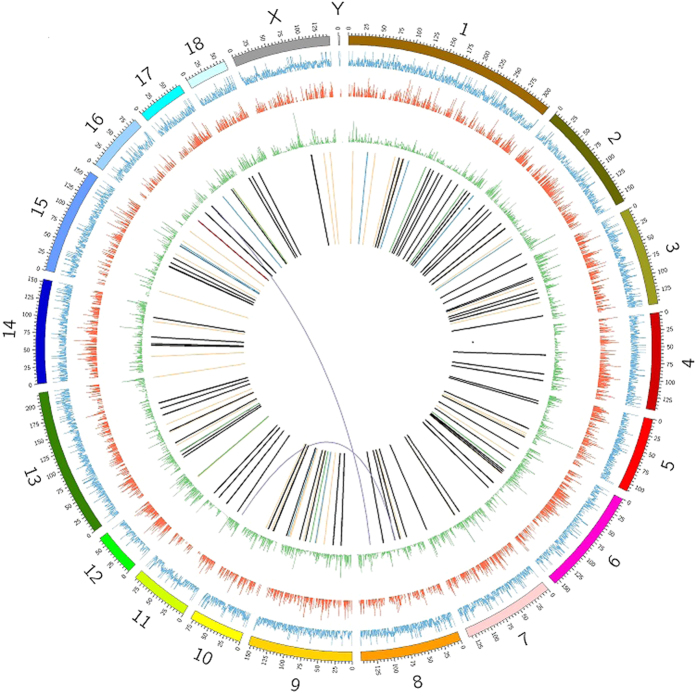
Transcriptome sequencing in prenatal porcine skeletal muscle.Chromosome ideograms are shown in the outer layer. The transcriptome sequencing coverage is shown in the first middle layer. Expression levels of genes are shown in the second middle layer. The SNP distribution is shown in the third middle layer. Chimeric RNAs are shown in the central layer. The chimeric RNA ssc-chimeric-113 is shown in red.